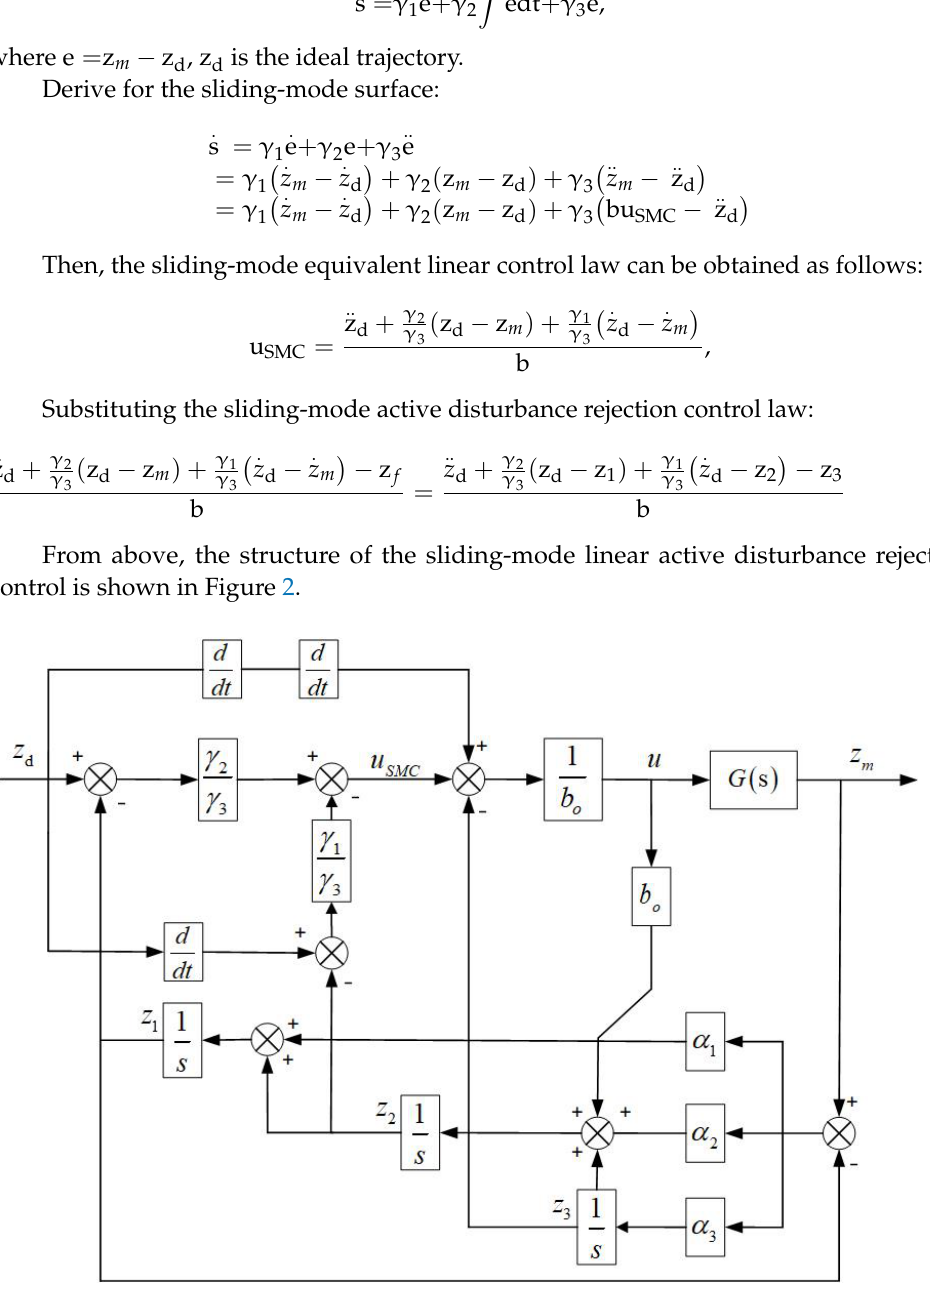
Figure 2. The control structure diagram.